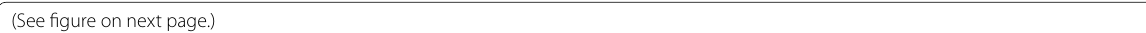
2, p < 0.005). Selected upregulated genes are shown. ≥ s.d. ( n 3). * p < 0.05, ** p < 0.01, + =